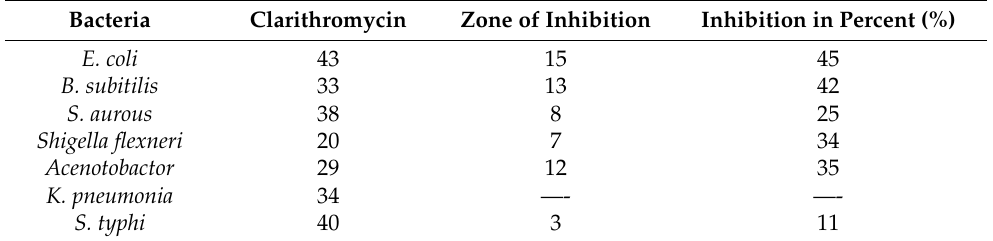
Table 1. Antibacterial activity of CuONPs.